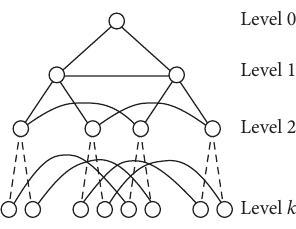
Figure 2: k -level hypertree HT ( k ) Table 1: Vertices partition of a hypertree ( k -level) based on degree and eccentricity of each vertex with the existence of its frequencies.